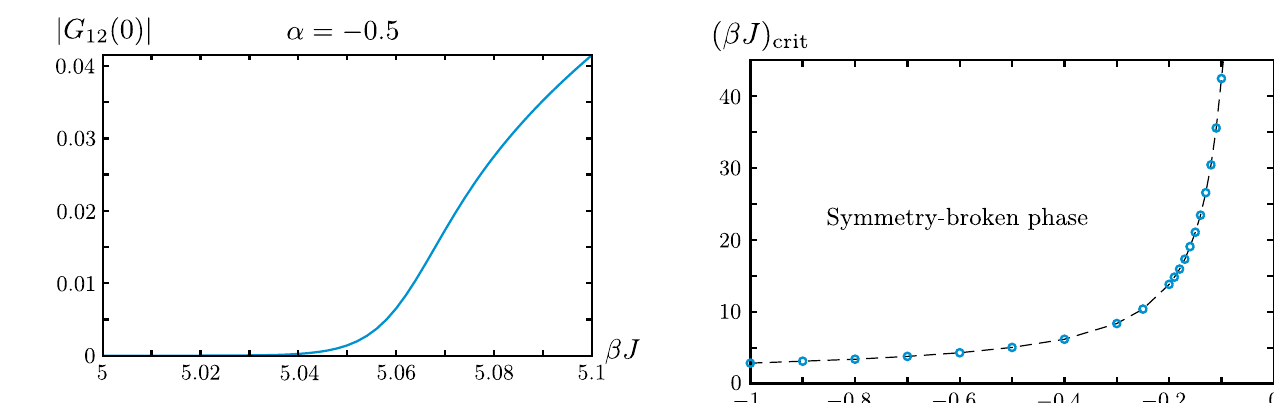
FIG. 10. The expectation value of Q=N function of β J for α ¼ − 0 . 5 . The region near ð β J Þ